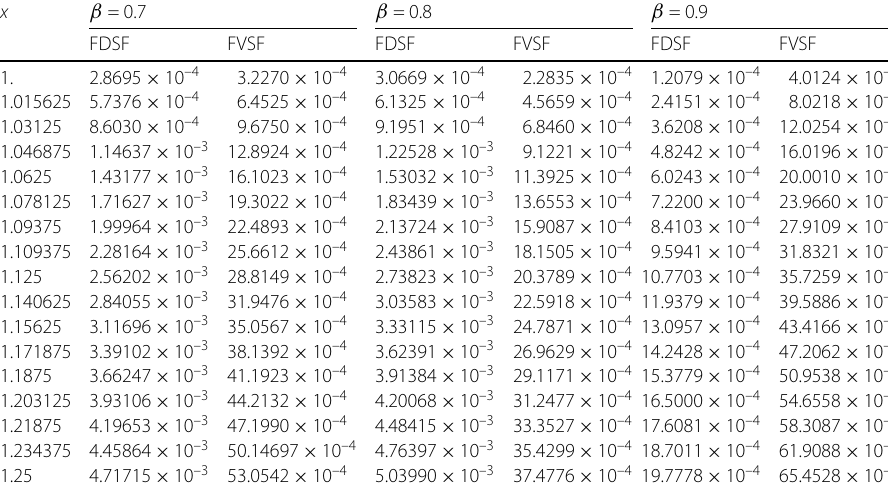
Table 1 Numerical results for Example 1 with varying β at time t = 1, fixed h = 0.015625 and τ = 0.01 using FDSF and